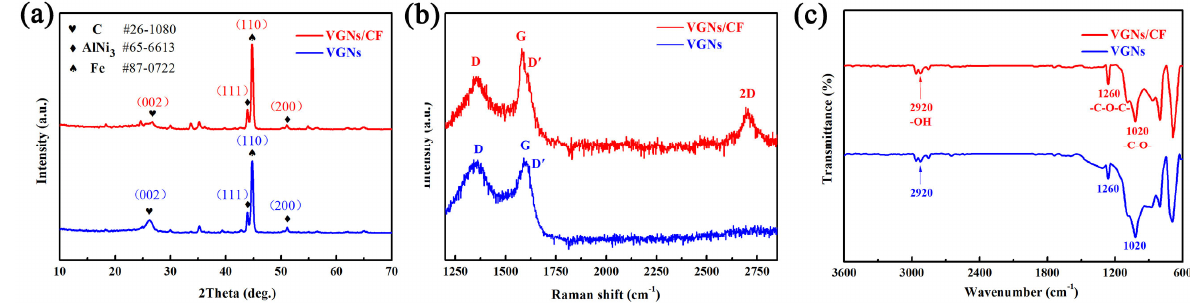
Figure 2. ( a ) XRD patterns, ( b ) Raman spectra, and ( c ) FT-IR spectra of the VGNs/CF composite films and the pure VGNs films prepared by different precursor solutions.